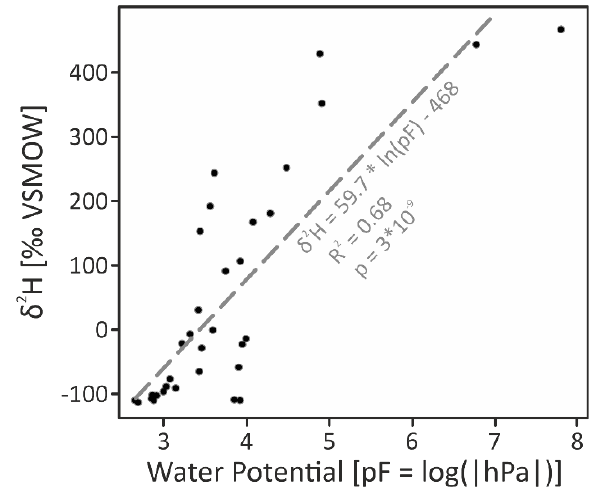
Figure 5. Relationship between δ 2 H and pF values in beech compartments of labelled mesocosms. Only incubation period from labelling until re-watering was considered.